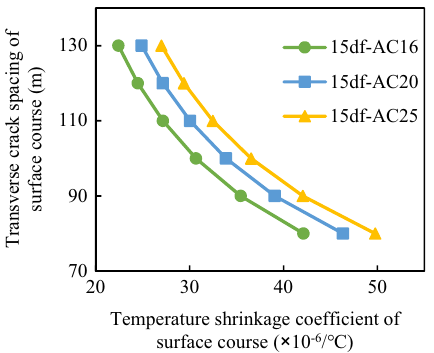
Figure 14. Relationship between transverse crack spacing and surface temperature shrinkage coefficient.